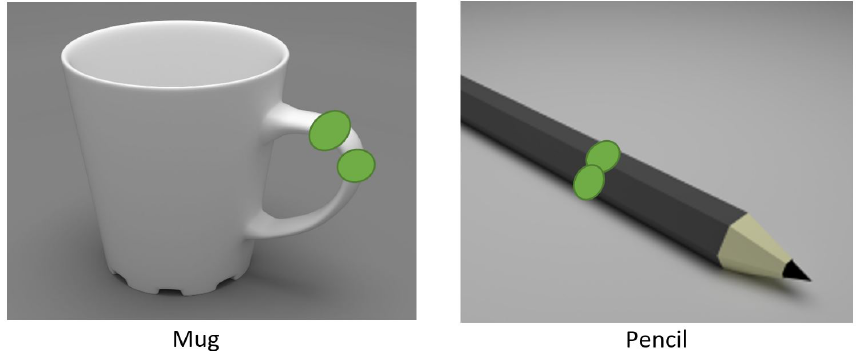
Figure 1. Example of the grasp point representation shown on 3D models of a mug and a pencil.